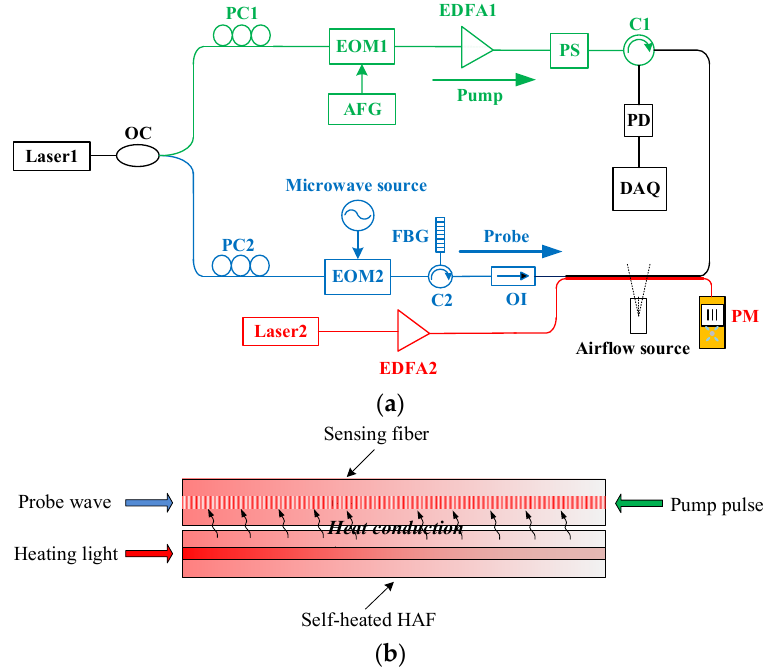
Figure 1. ( a ) The experimental setup and ( b ) schematic diagram of the fiber layout. OC: Optical coupler; PC: Polarization controller; EOM: Electro-optic modulator; AFG: Arbitrary function generator; EDFA: Erbium-doped fiber amplifier; PS: Polarization scrambler; C: Circulator; PD: Photodetector; DAQ: Data acquisition card; FBG: Fiber Bragg grating; OI: Optical isolator; PM: Power meter.